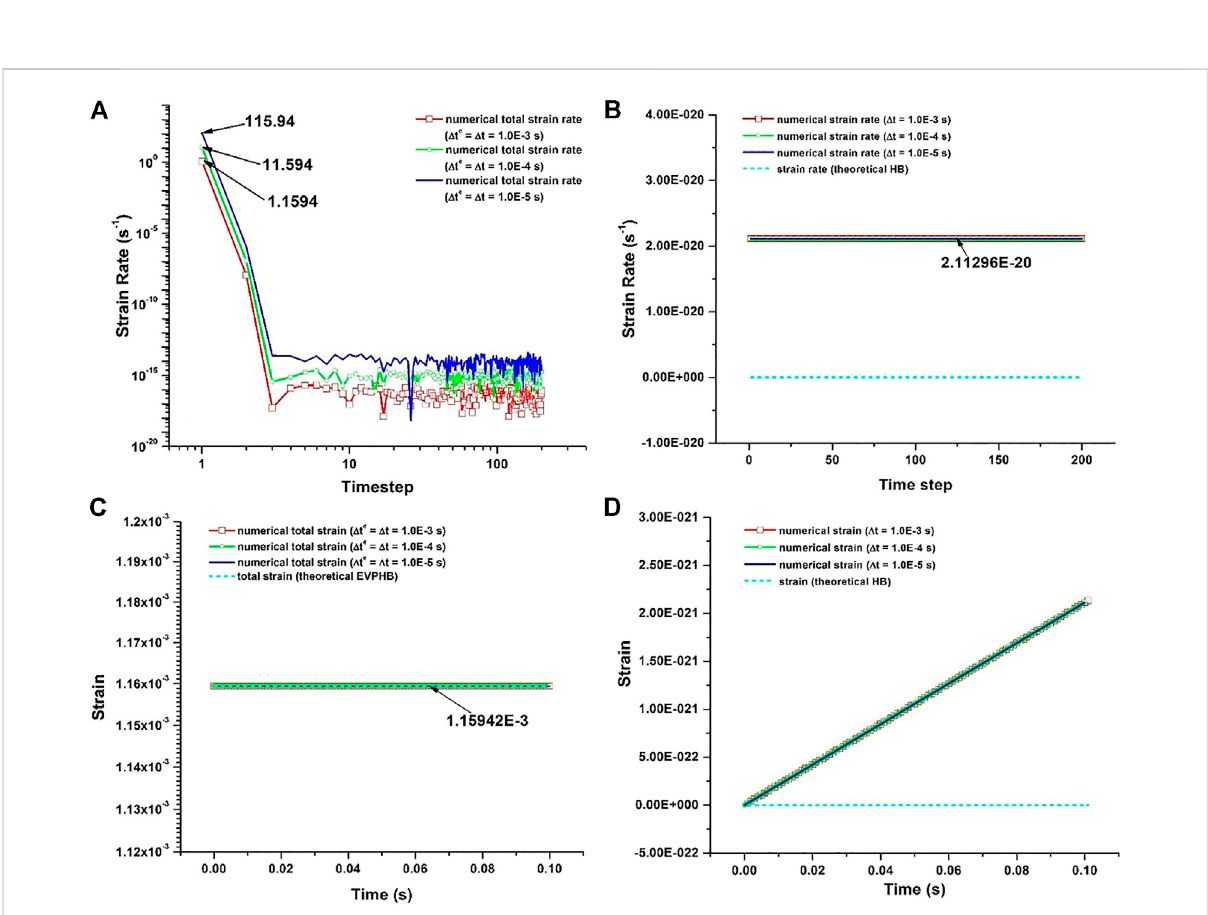
Shear stress lower than yield stress. The total shear strain rate and strain produced by EVPHB model were separately plotted in (A) and (C) , the shear strain rate and strain produced by RHB model were separately plotted in (B) and (D)